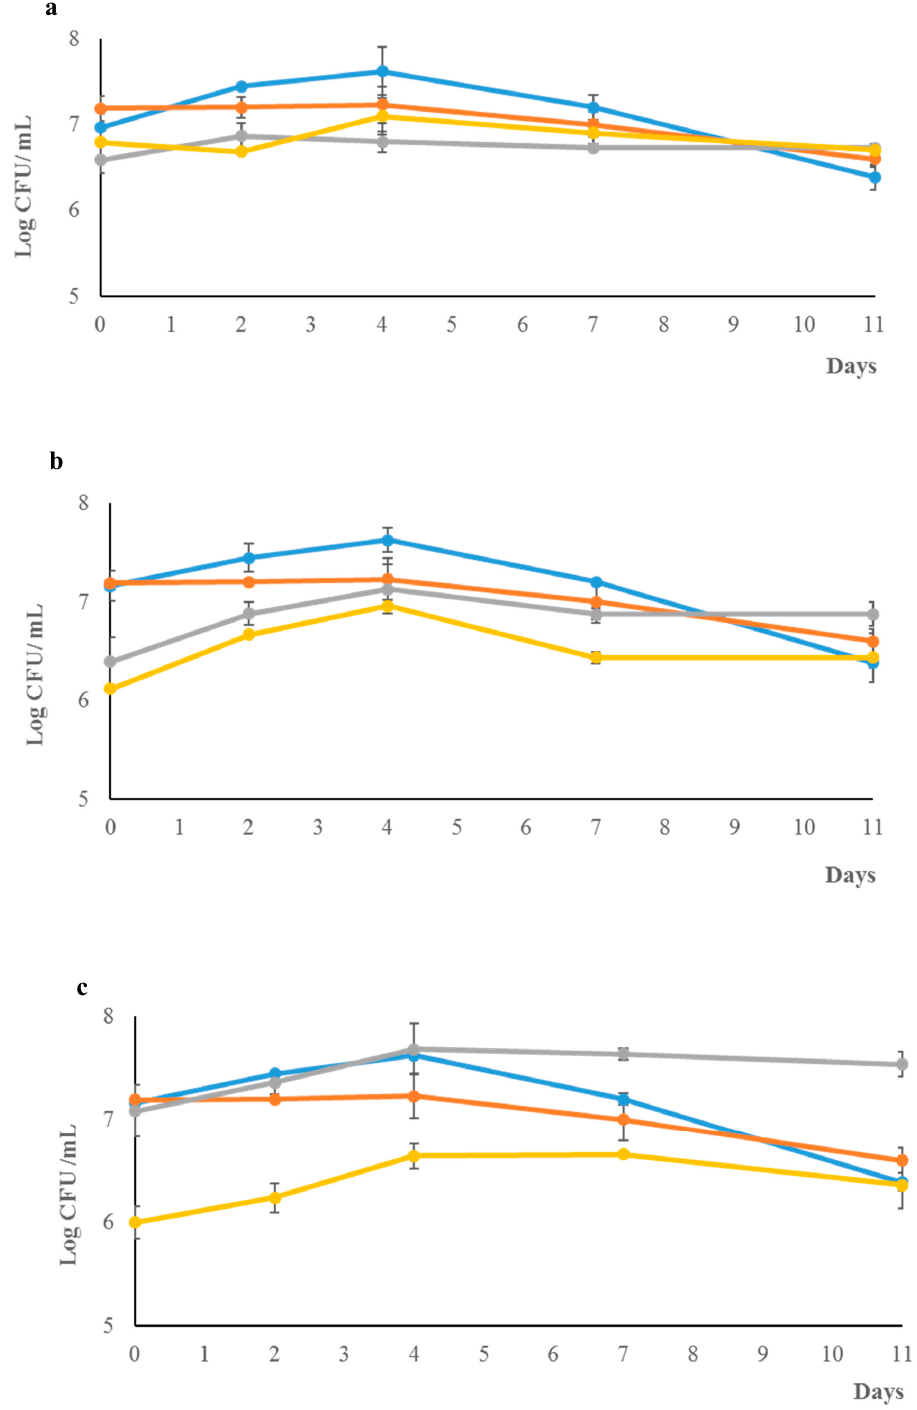
Figure 2. Growth kinetics of Z. florentina in pure and mixed fermentation. Pure cultures of Z. florentina ( ) and S. cerevisiae ( ) and for the mixed fermentation with . S. cerevisiae ( ) and Z. florentina ( ) individually in the mixed cultures at 1:1 ( a ), 1:10 ( b ) and 1:20 ( c ).